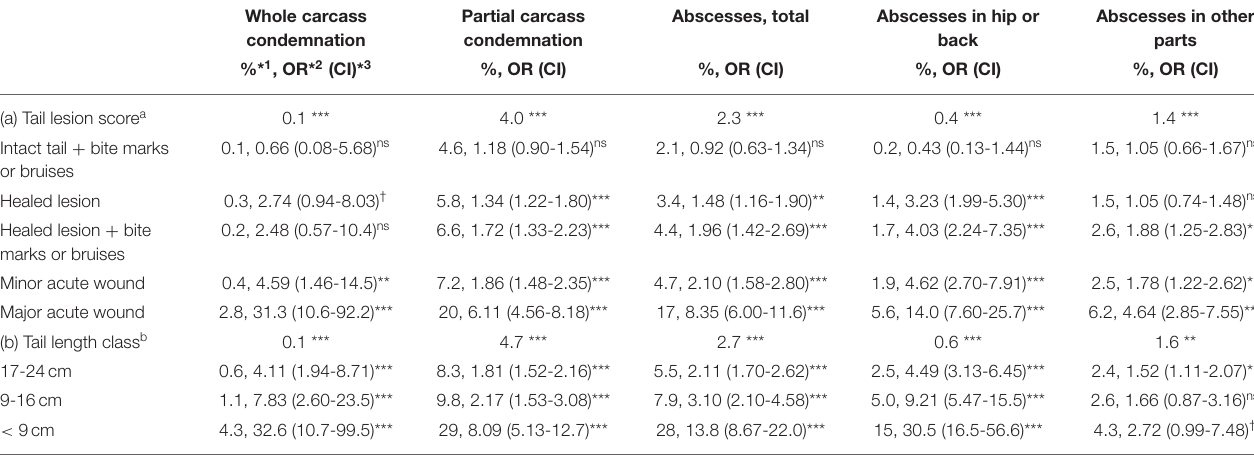
TABLE 4A | Results from logistic regressions on the association between (a) tail lesion score and (b) tail length class (separate models) and carcass condemnations as well as abscesses recorded at meat inspection ( n =